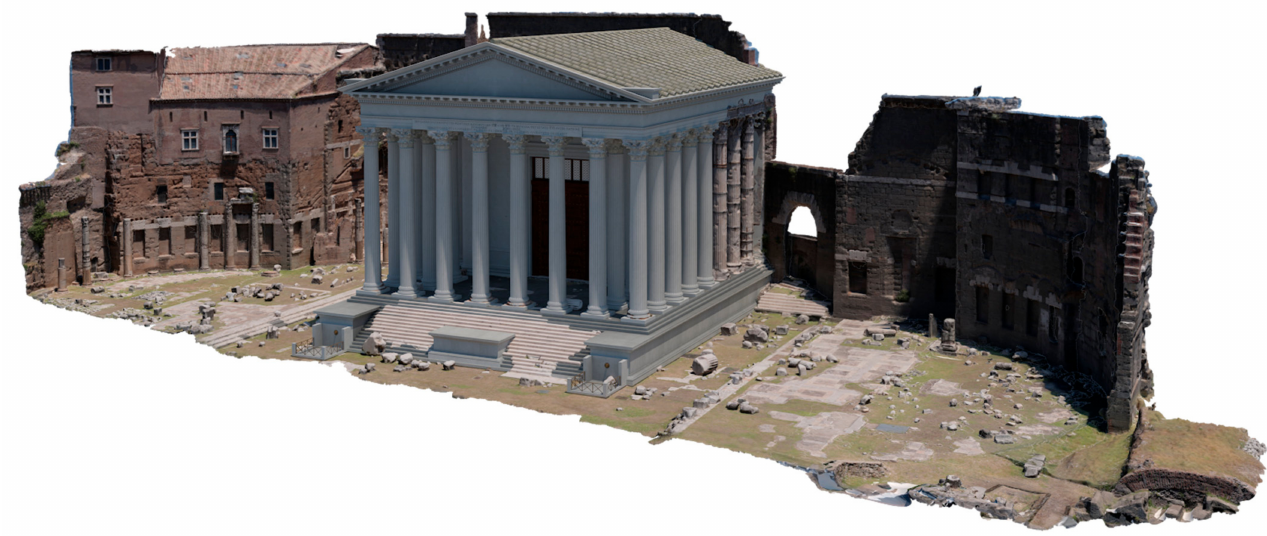
Figure 13. Virtual reconstruction of the Temple of Mars Ultor. The reconstruction is modeled and rendered on the digital replica of the site. This kind of visualization allows the recognizability of the original